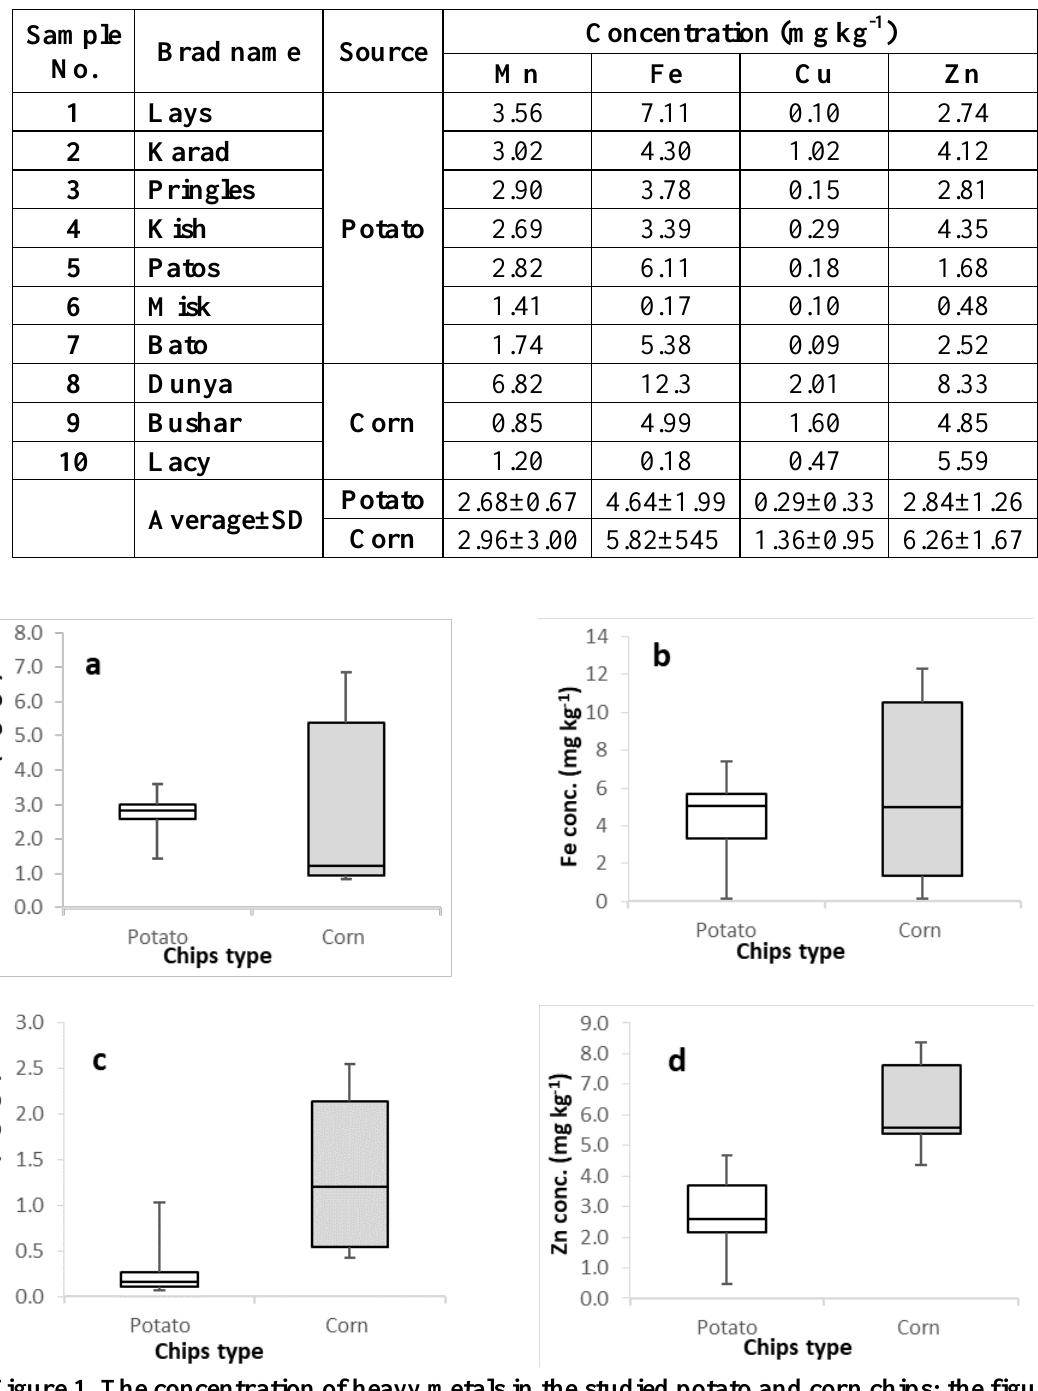
Table 3. Heavy metals concentrations in potato and corn chips Sample